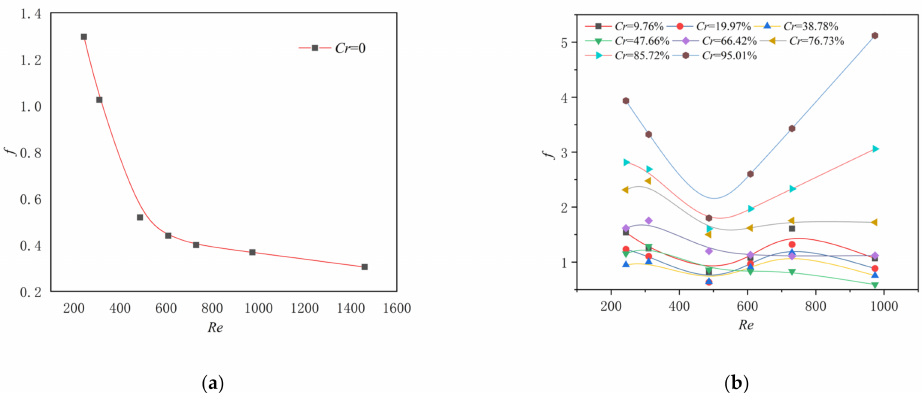
Figure 8. Relationship between resistance coefficient ( f ) and Reynolds number ( Re ): ( a ) without vegetation cover; ( b ) with vegetation